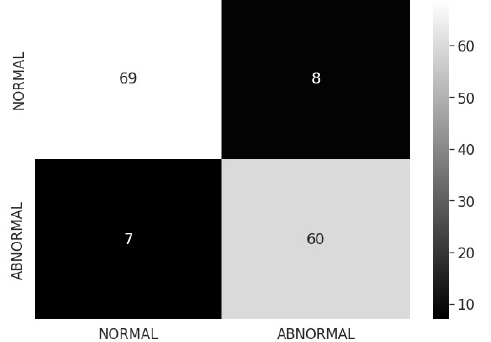
Figure 3. Confusion matrix for proposed model normal/abnormal classification.